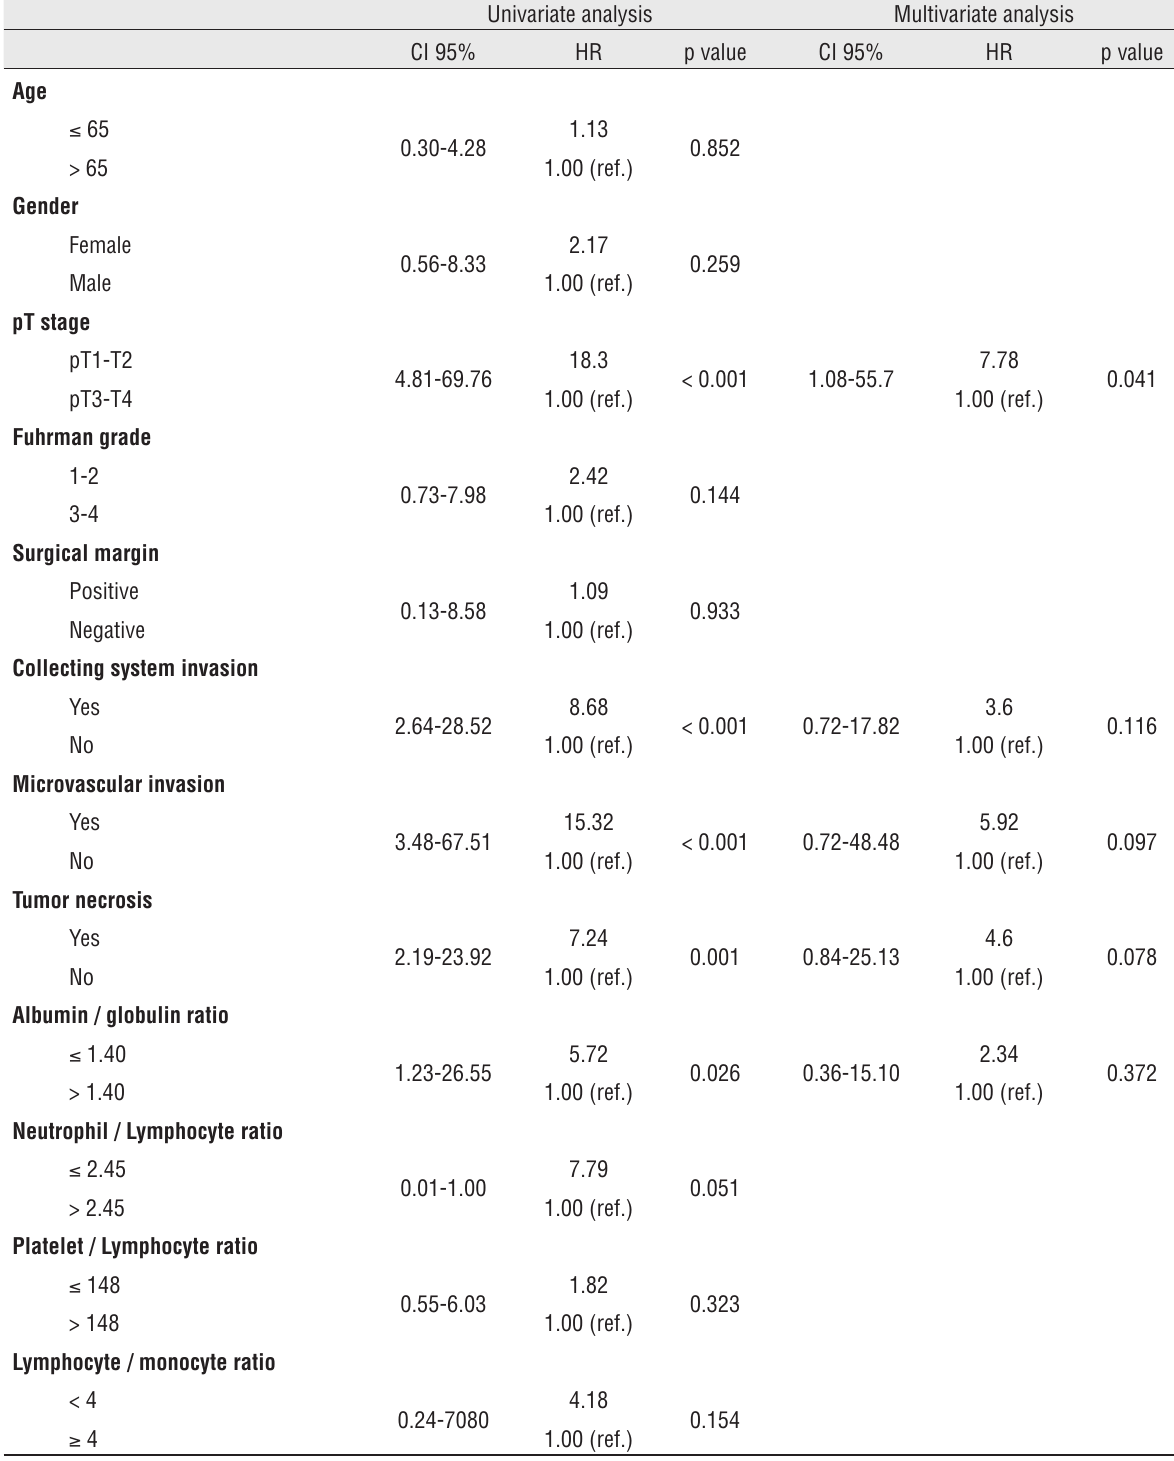
Table 3 - Univariate and multivariate Cox regression analyses of prognostic factors for disease-free survival. Univariate analysis Multivariate